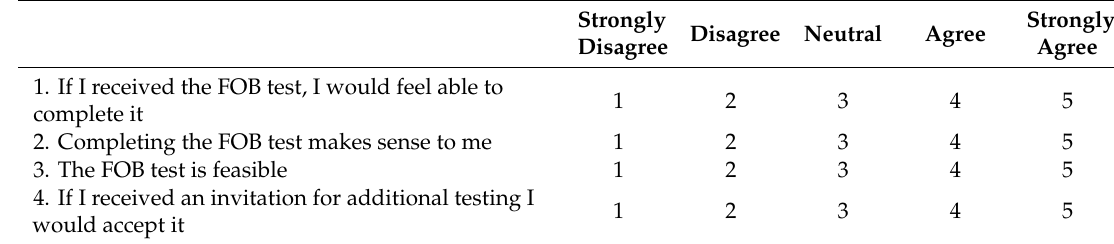
Table A2. Self-e ffi cacy Questionnaire.